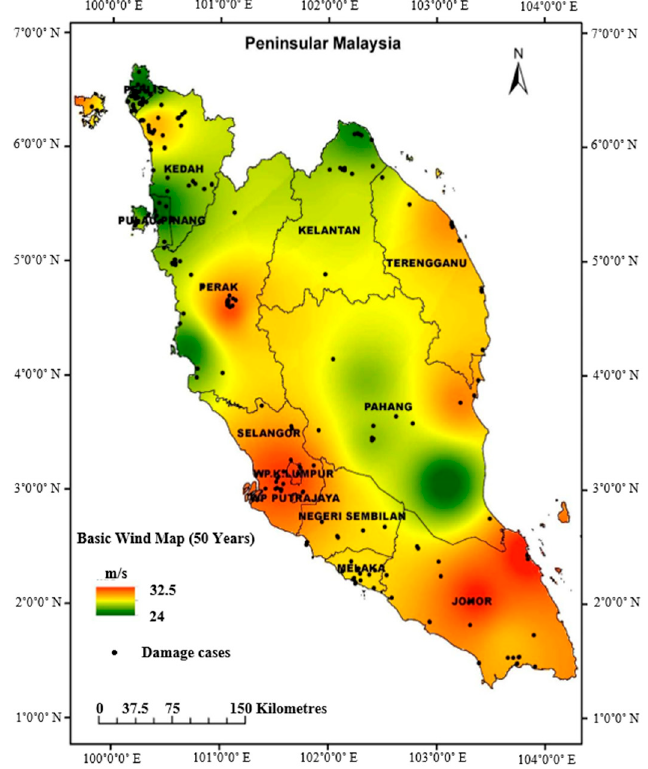
Figure 9. Basic wind speed ( V s ) of Peninsular Malaysia.